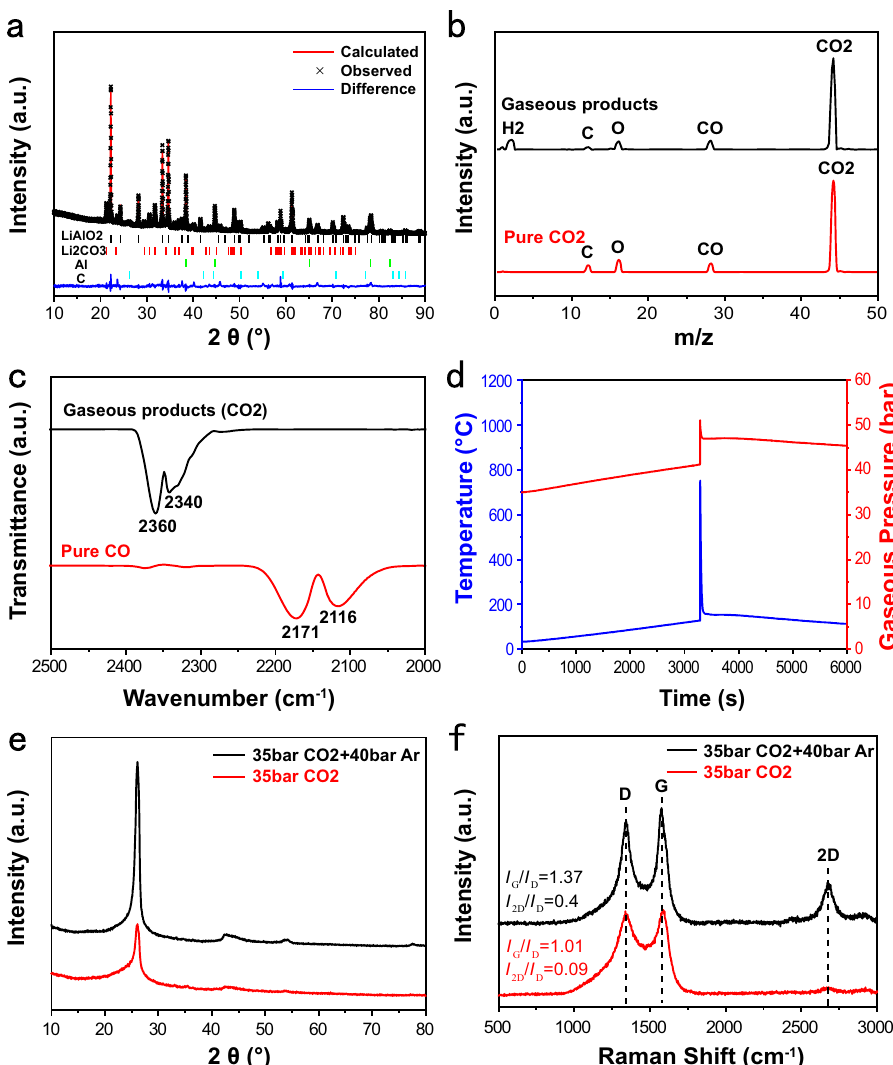
Fig. 3 Characterization of the products of CO 2 reacting with LiAlH 4 . a Rietveld re fi nement of the XRD pattern of the solid products of CO 2 reacting with LiAlH 4 . b The mass spectrum of the gaseous products and pure CO 2 . c FTIR spectrum of gaseous products and pure CO. d Time dependence of temperature and gas pressure in the reactor during 35 bar CO 2 reacting with LiAlH 4 . e XRD patterns and f Raman spectra of carbon synthesized by reacting 35 bar CO 2 with LiAlH 4 under the gaseous back pressures of 35 and 75